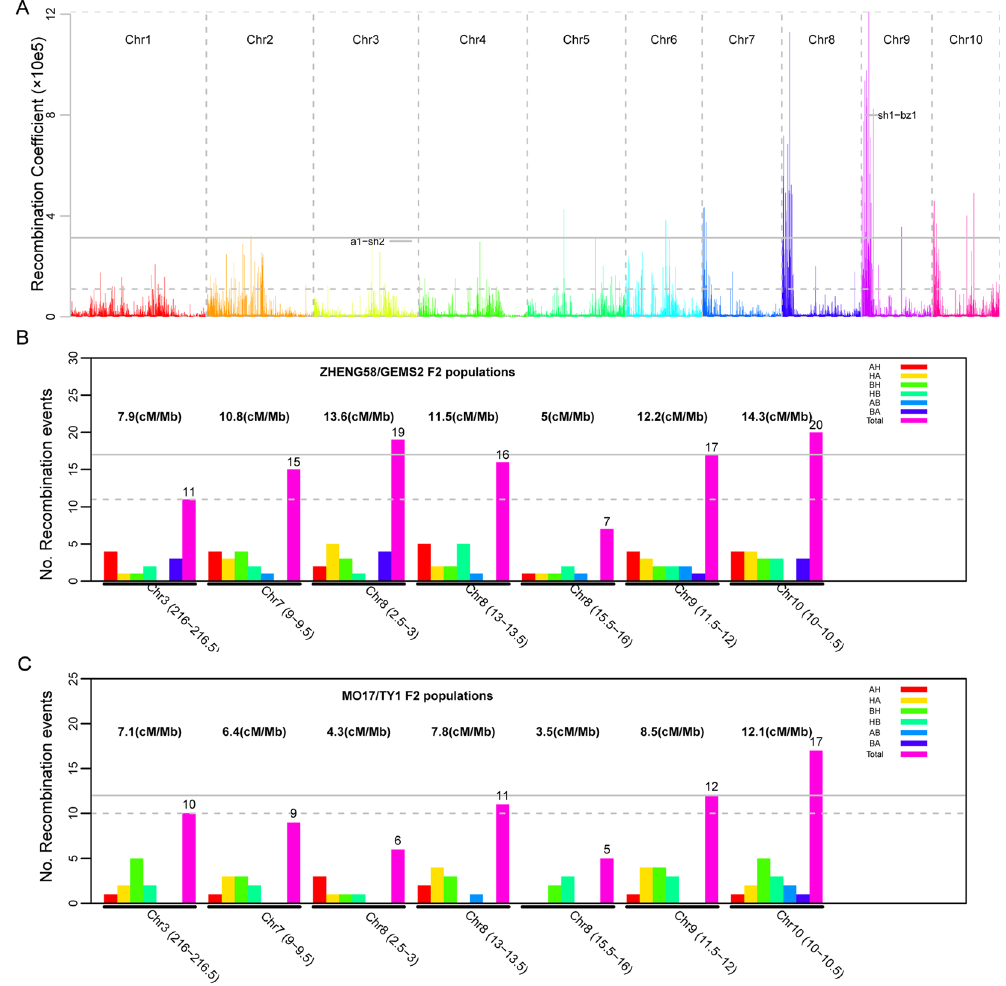
Figure 4. Distribution and validation of novel recombination hot spots in maize. ( A ) Distribution of recombination coefficient indicated a large number of recombination hot spots across the maize genome. Two putative recombination hot spots of a1-sh2 and sh1-bz1 were labelled. The gray solid line is the threshold for top 1% recombination coefficients. The Gray dashed line is the threshold line for top 5% recombination coefficients. ( B ) and ( C ) High-density genotypeing validation of five randomly selected recombination hot spots in two F 2 populations - ZHENG/GEMS2 and Mo17/TY1. A, B, and H in ( B ) and ( C ) graphs represent the genotypes of parent 1, parent 2, and heterozygosity, respectively. The number of crossover was obtained by counting the number of individuals with genotype switching in the target recombination region. For example, AH means there was a genotype switch from parent 1 to heterozygosity. The gray solid line shows the recombination rate at the sh1-bz1 locus, while Grey dashed line shows the recombination rate of the a1-sh2